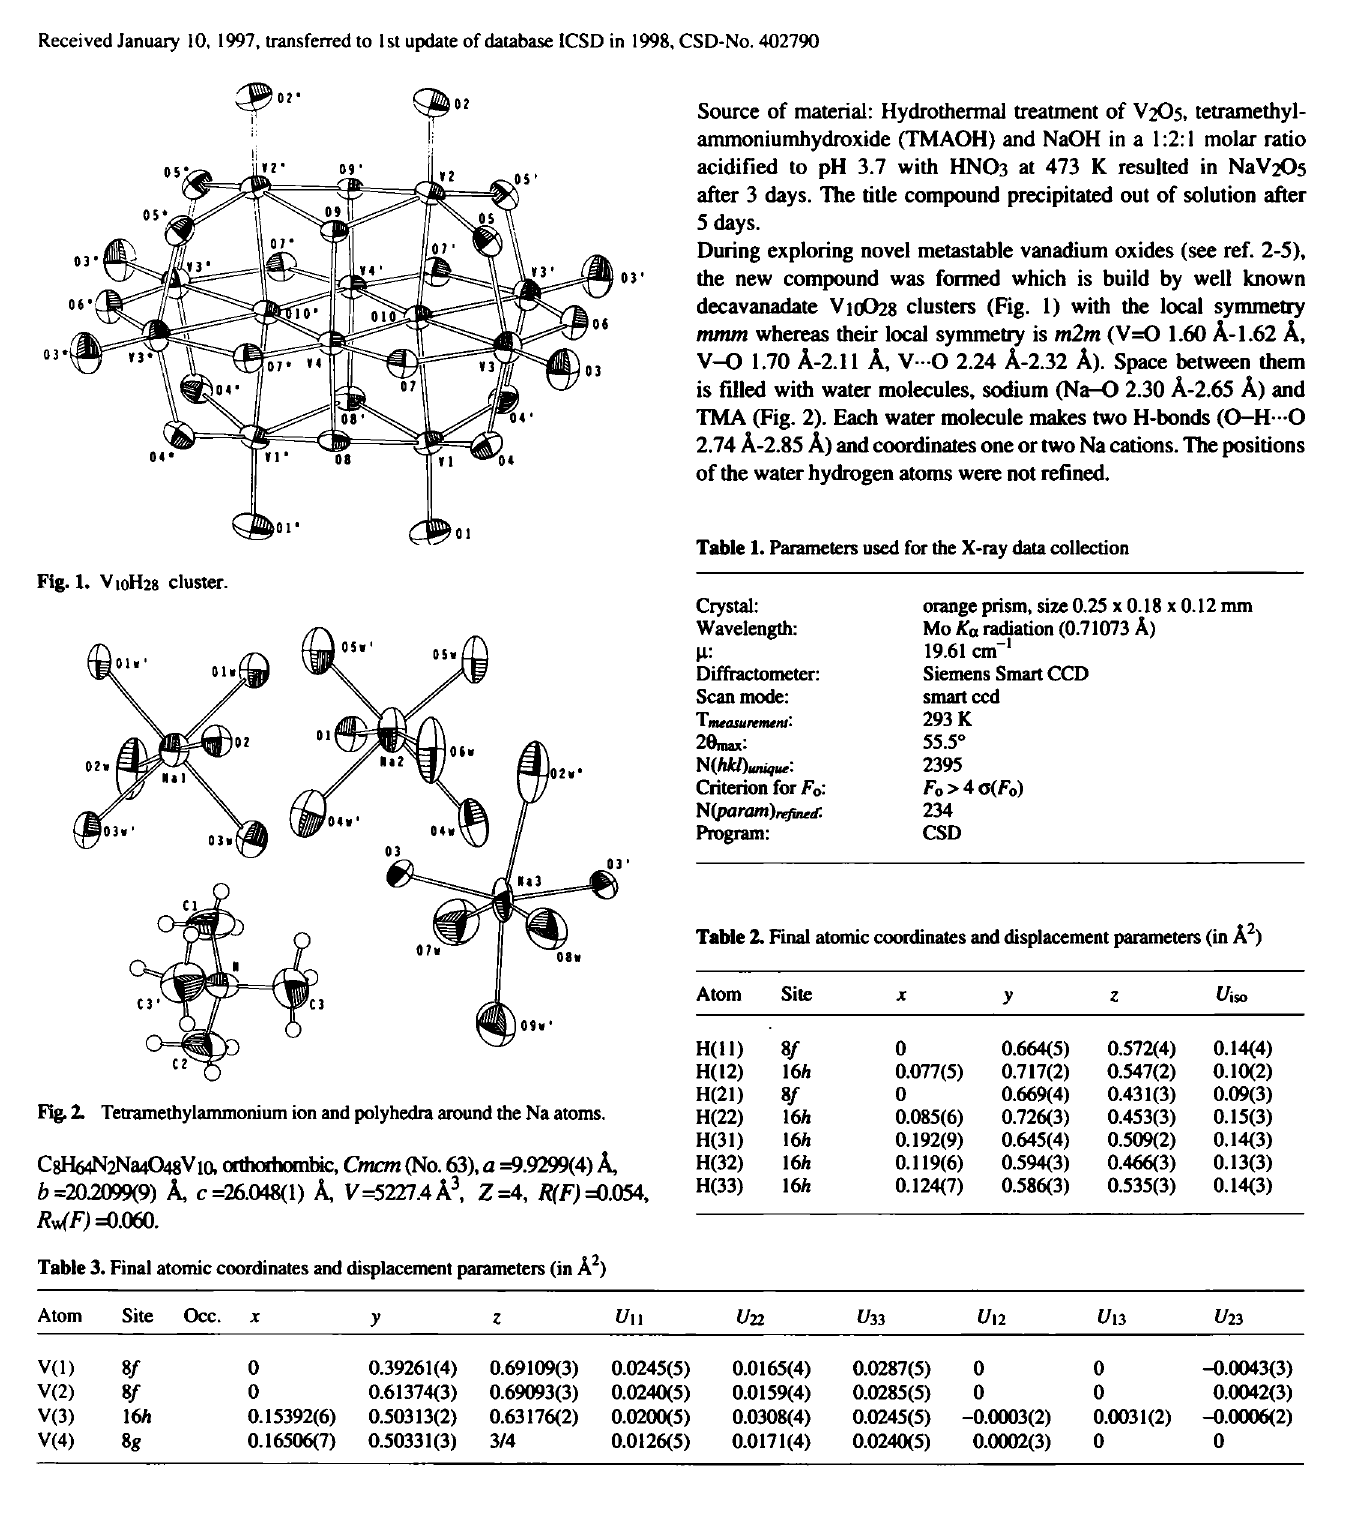
Table 2. Final atomic coordinates and displacement parameters (in Â 2